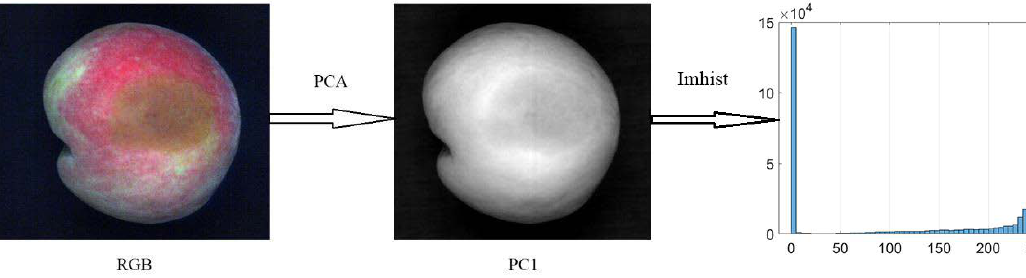
Figure 4 . The common procedure for image processing.